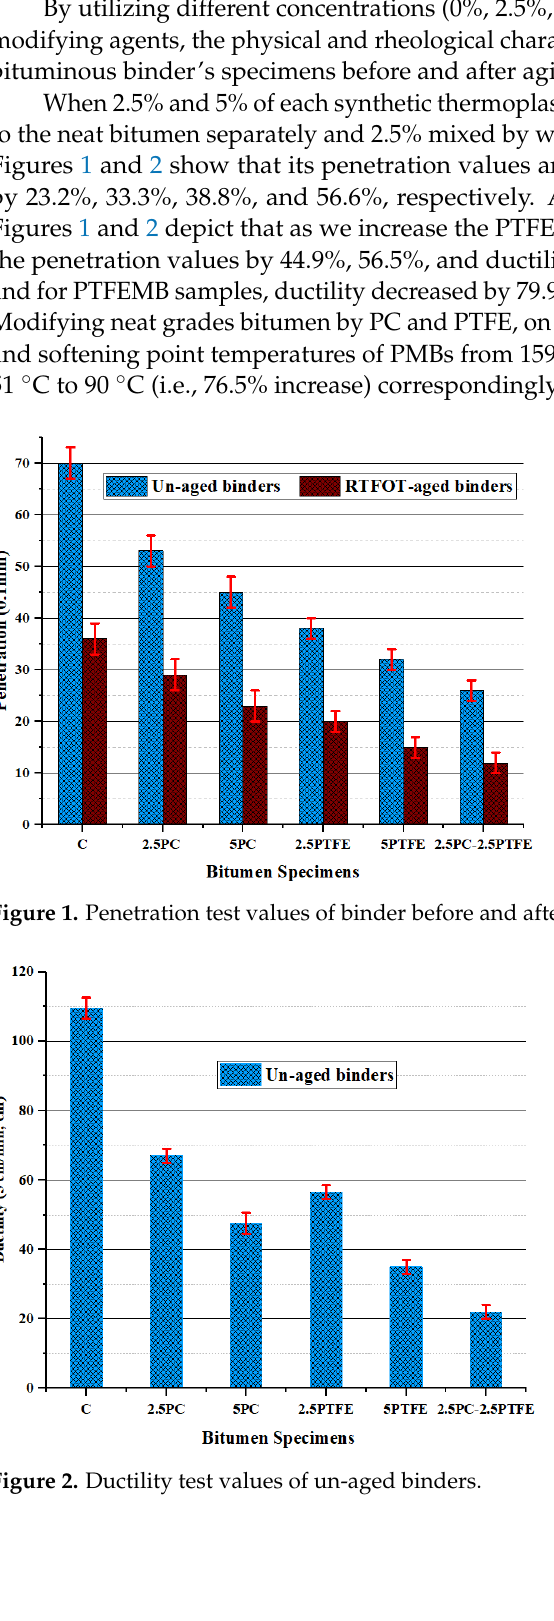
Figure 3. Flash and fire point temperature values of binders.